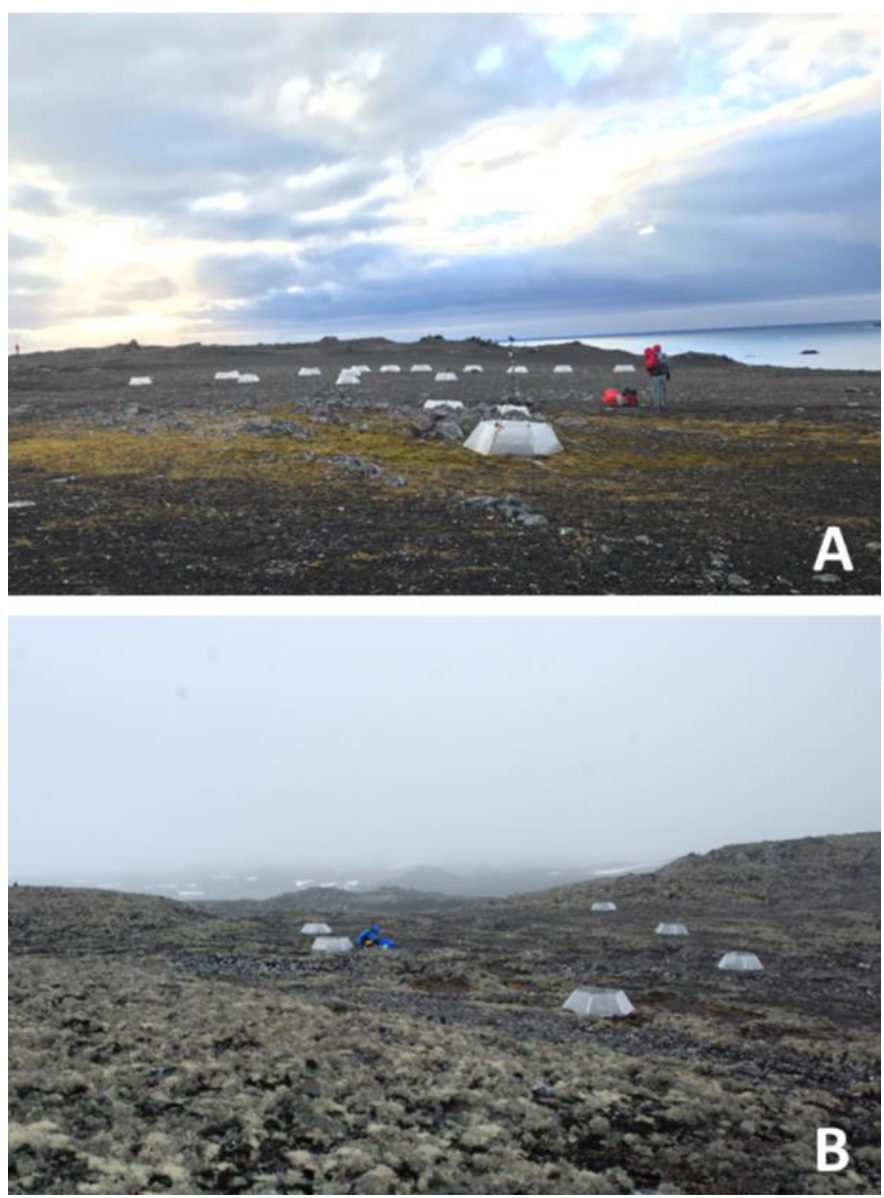
Figure 8. Open-top chambers (OTCs) installed in 2008 in Fildes Peninsula, King George Island, South Shetland Islands, west coast of the Antarctic Peninsula. ( A ) Punta Juan Carlos and ( B ) Meseta La Cruz. Photo credit: A. Casanova-Katny.